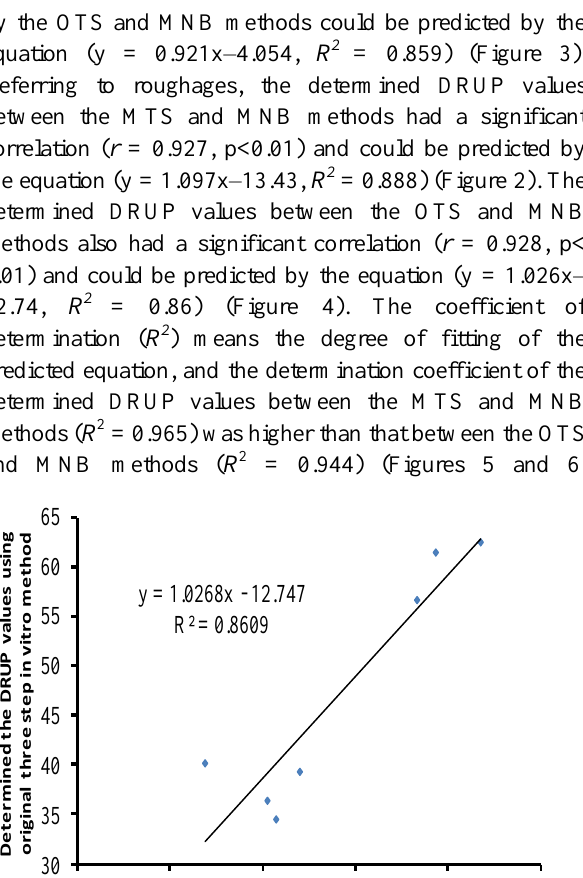
Figure 1. Predicted analysis between MNB observed values and MTS observed value in the concentrates. MNB, mobile nylon bag method; MTS, modified three-step in vitro method.